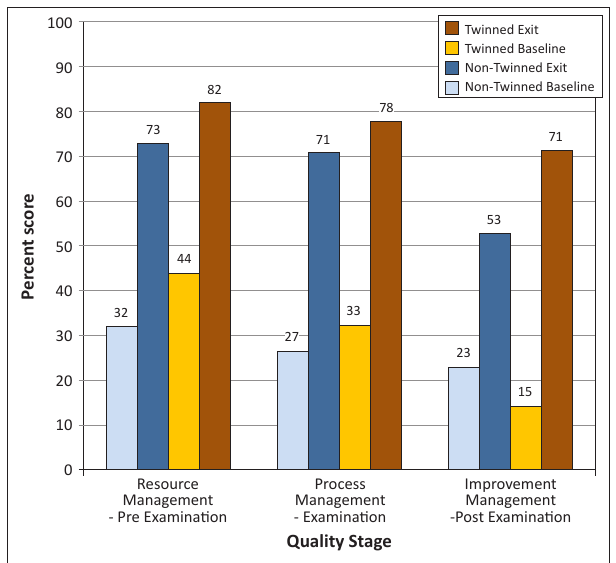
FIGURE 3: Average performance of twinned and non-twinned laboratories by quality cycle stages at baseline and exit of the Strengthening Laboratory Management Toward Accreditation (SLMTA)